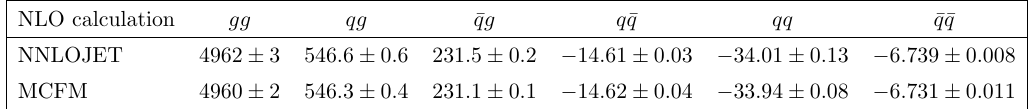
Table 1 . The NLO contribution (cid:14) NLO , de(cid:12)ned in eq. (3.2), broken down into individual partonic channels, as computed by NNLOJET and MCFM (dipole subtraction). Cross-sections are shown in